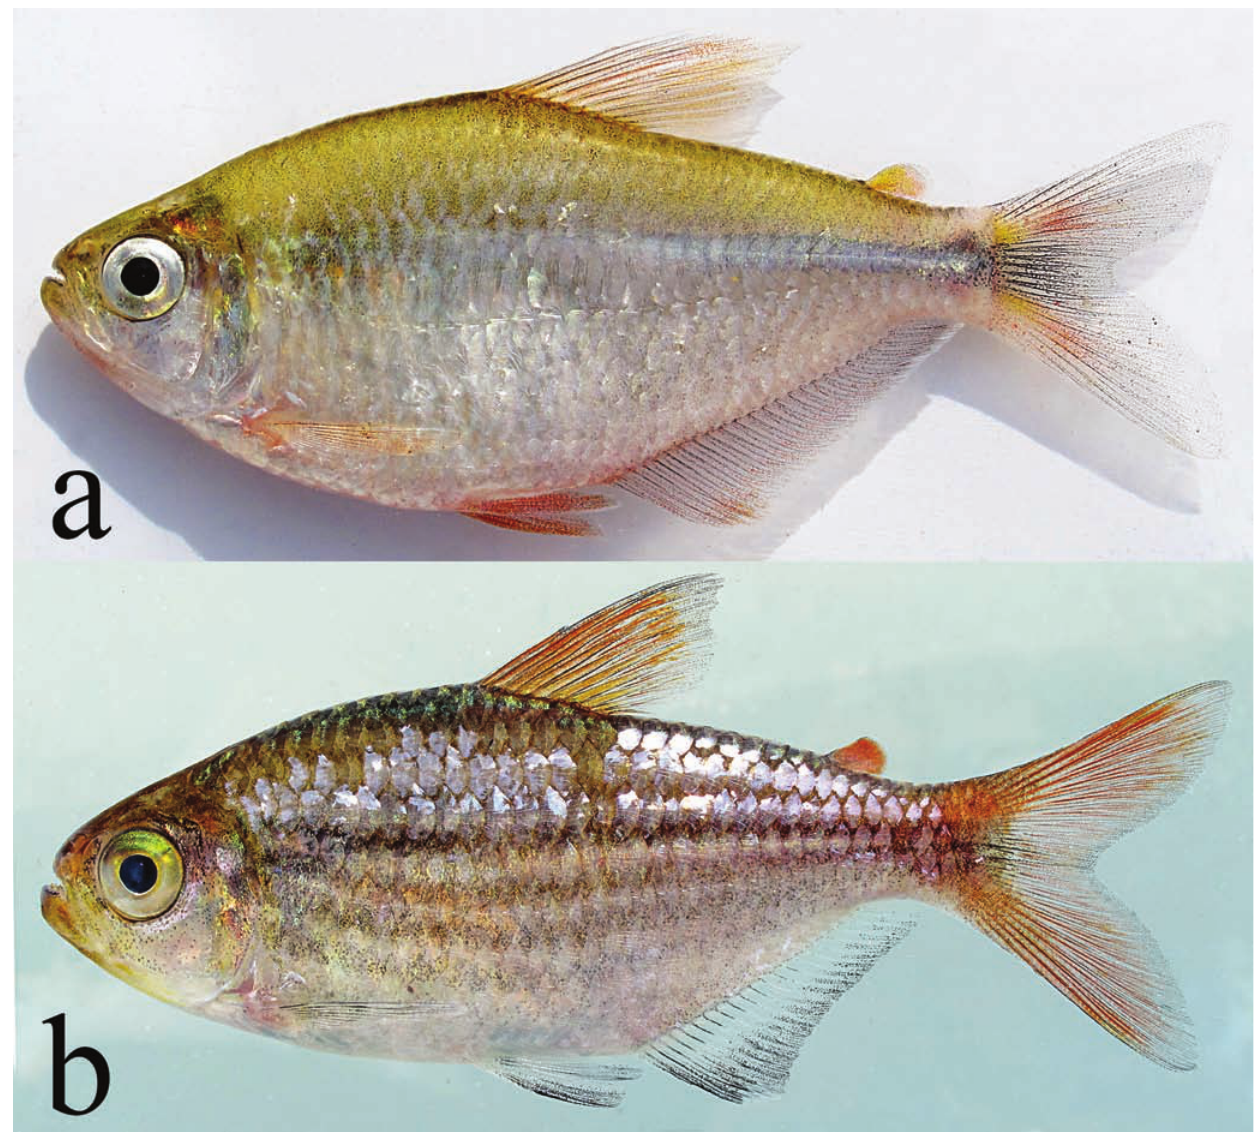
Fig. 6. Live specimens of: (a) Moenkhausia aurantia , MZUSP 113835, 48.3 mm SL, Brazil, Goiás, rio Tocantins basin; (b) Moenkhausia nigromarginata , MZUEL 8009, 50.0 mm SL, Brazil, Mato Grosso, rio Tapajós